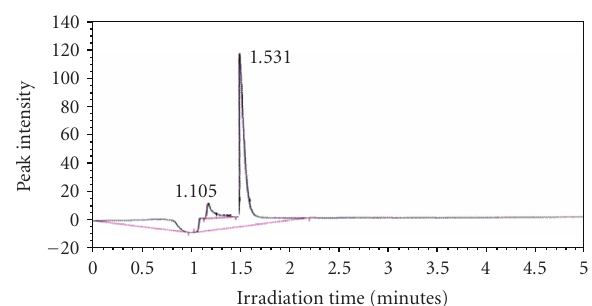
Figure 4: HPLC analysis of authentic sarcosine in aqueous solution.